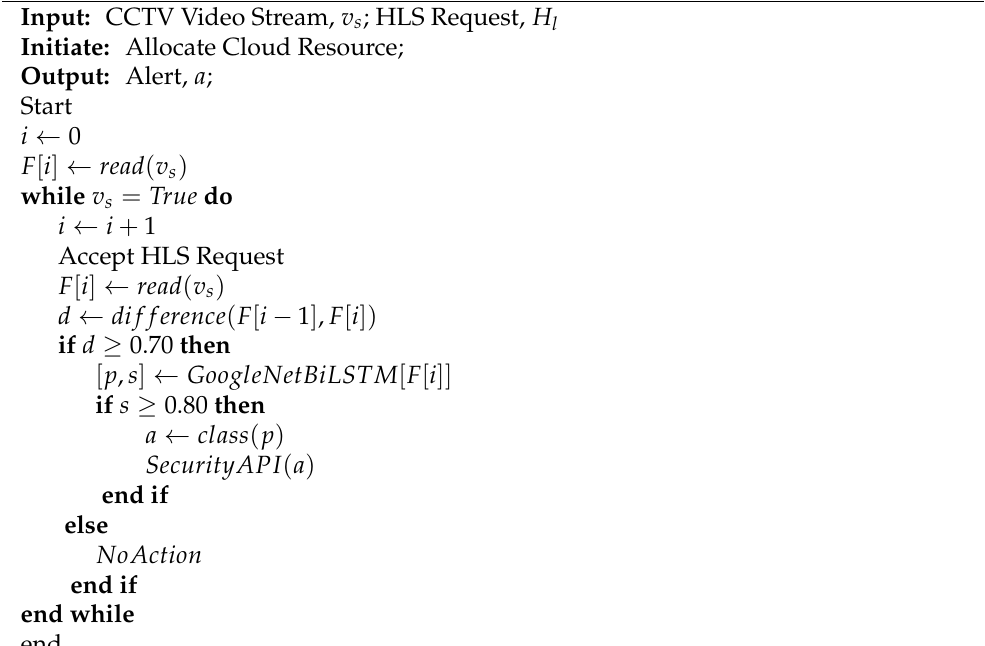
Algorithm 2 The HAR-CPS Algorithm